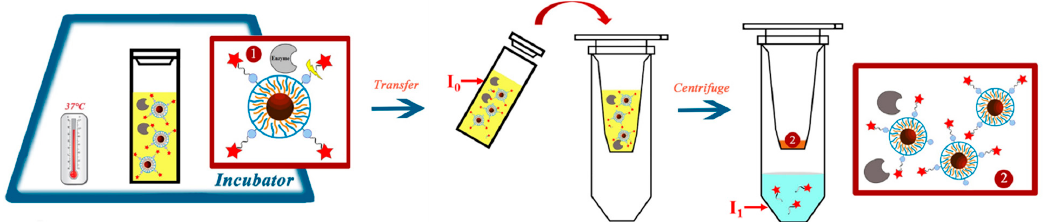
Figure 6. Measurement protocol for recording the fluorescence of the original NP solution (I 0 ) and the fluorescence of dyes/polymer fragments released from the NPs upon enzymatic cleavage (I 1 ).